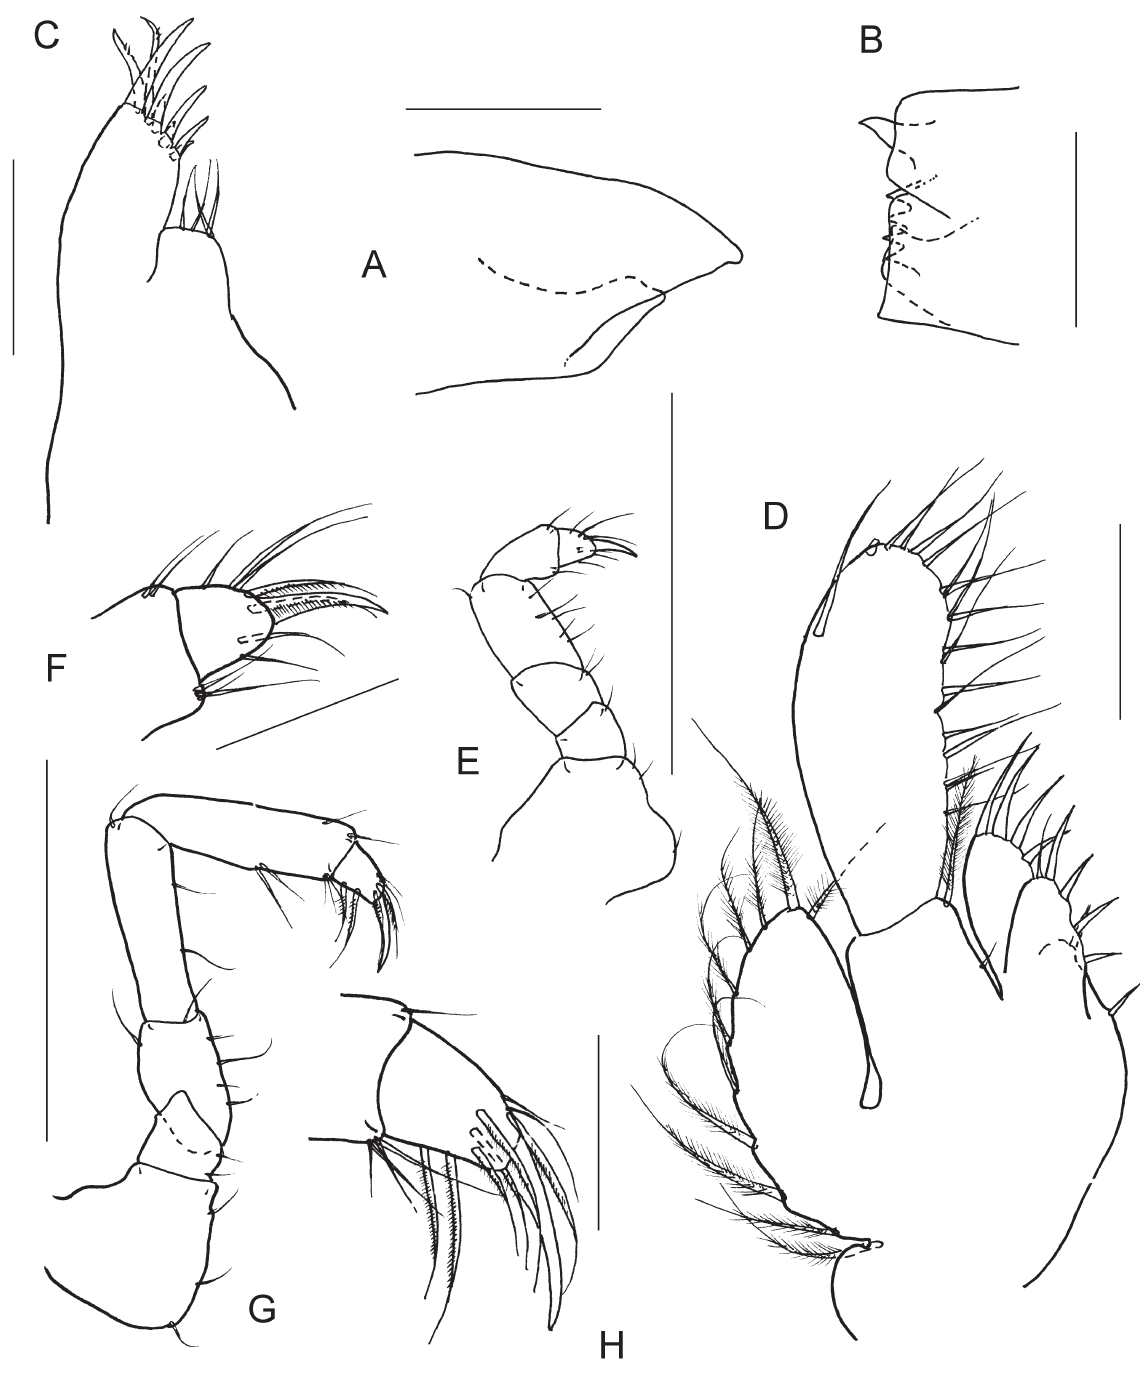
Fig. 33. Siriella cf. chaitiamvongae Murano & Fukuoka, 2008, subadult ♂, Singapore. A . Left mandible. B . Right mandible. C . Maxilla 1, anterior view. D . Maxilla 2, anterior view. E . Maxilliped 1, posterior view. F . Distal part of maxilliped 1, posterior view. G . Maxilliped 2, posterior view. H . Distal part of maxilliped 2, posterior view. Scale bars: A–D, F, H = 0.05 mm; E, G = 0.1